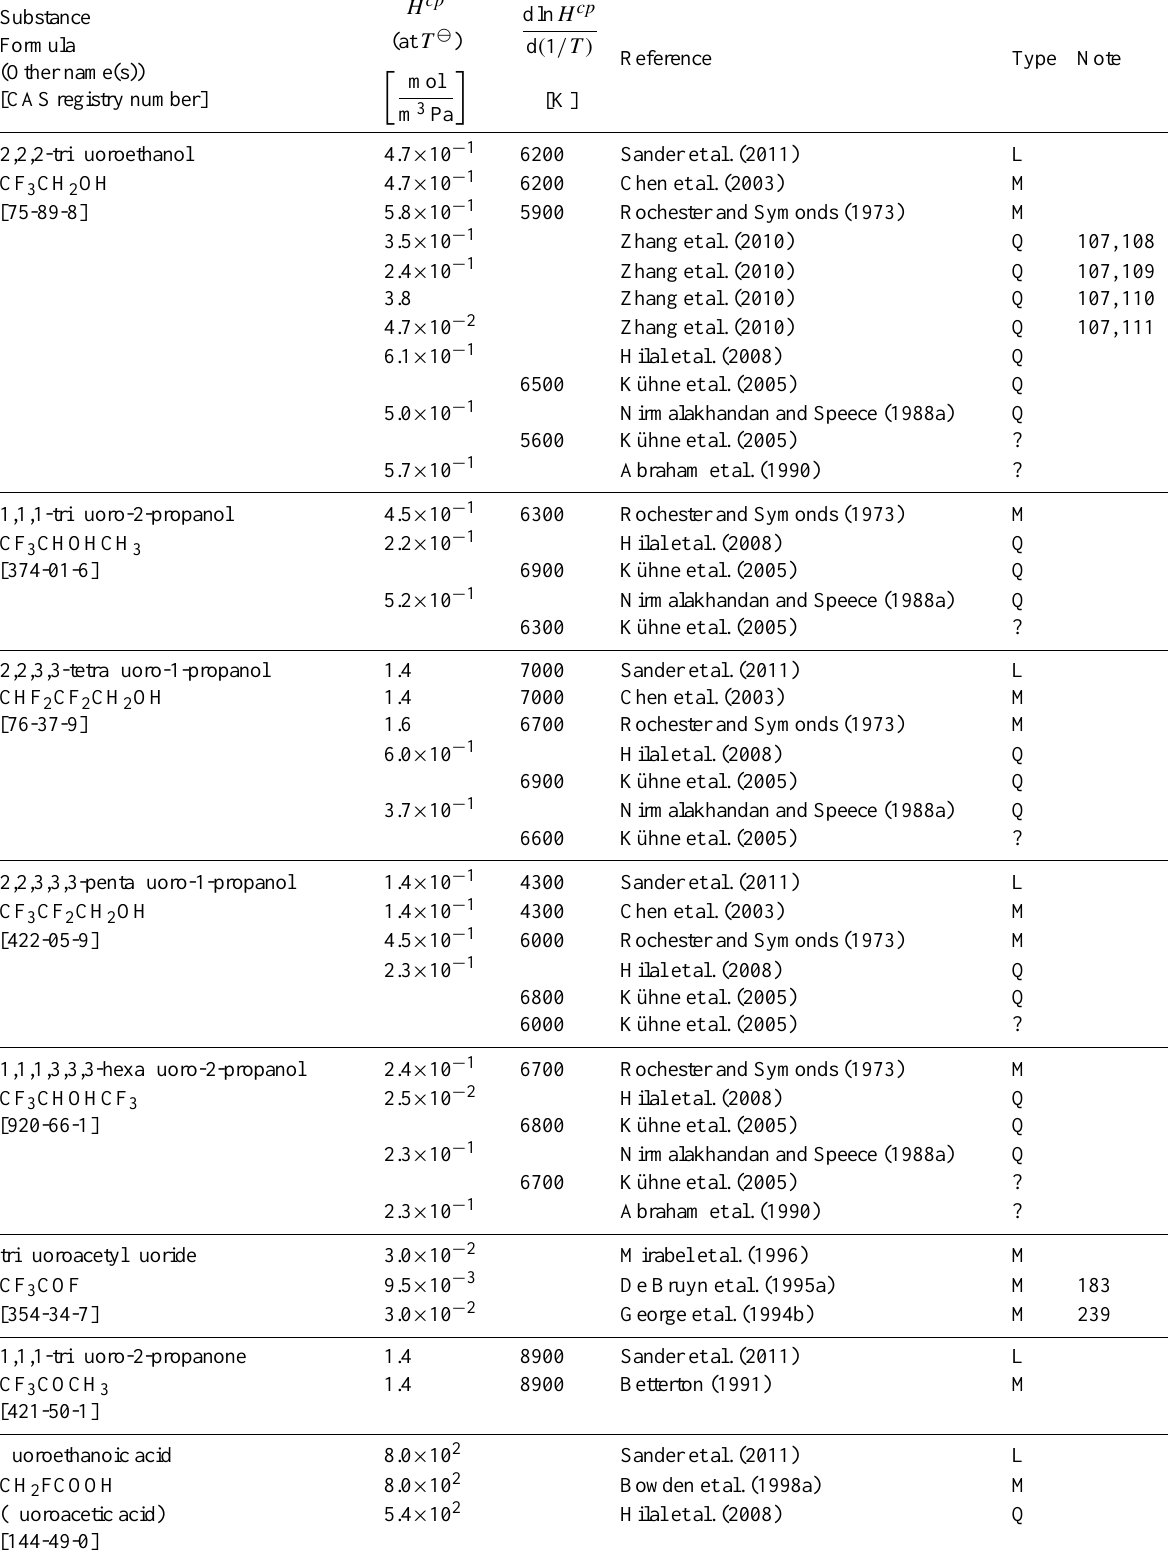
Table 6: Henry’s law constants for water as solvent